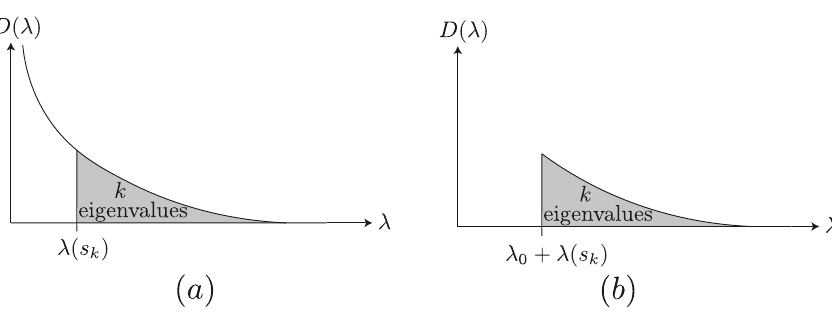
Figure 4 . (a) The thermal spectrum of the JT black hole. (b) The approximate spectrum of ρ R is a cutoff thermal spectrum which is obtained by truncating the spectrum to the k largest 1 R 2 eigenvalues and shifting it by λ 0 to make it